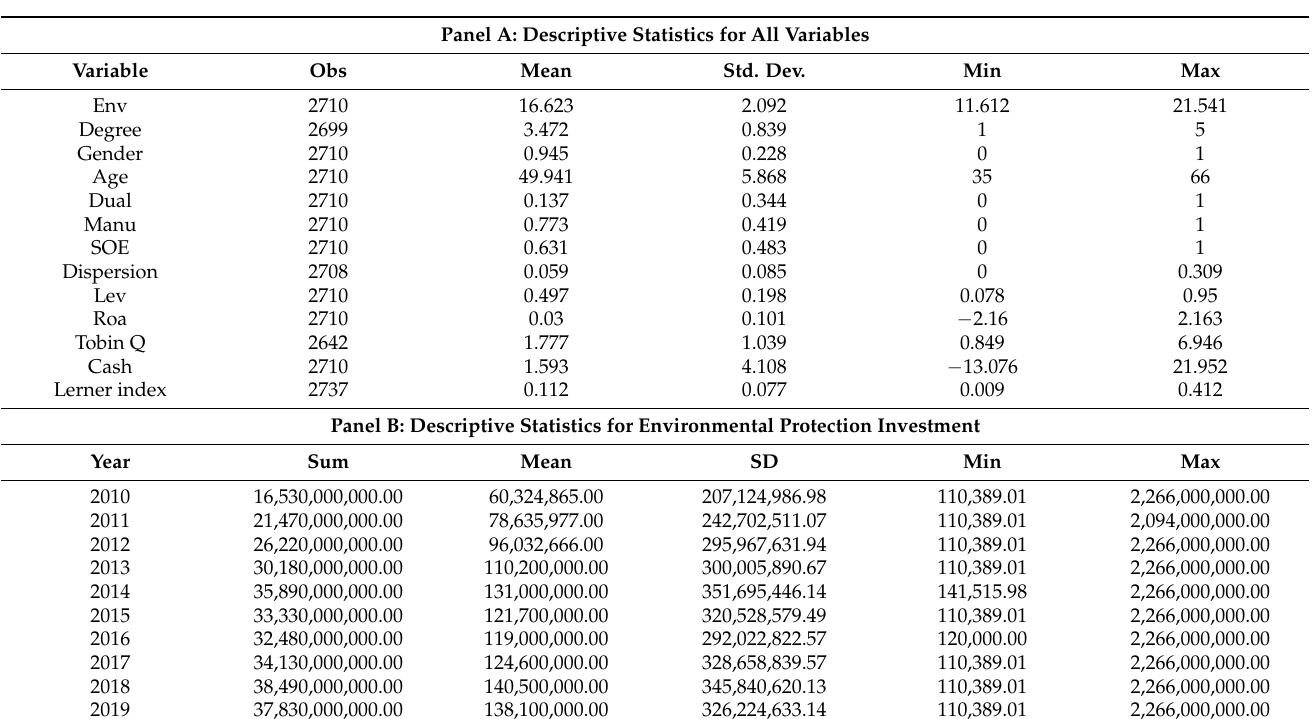
Table 2. Descriptive statistics.